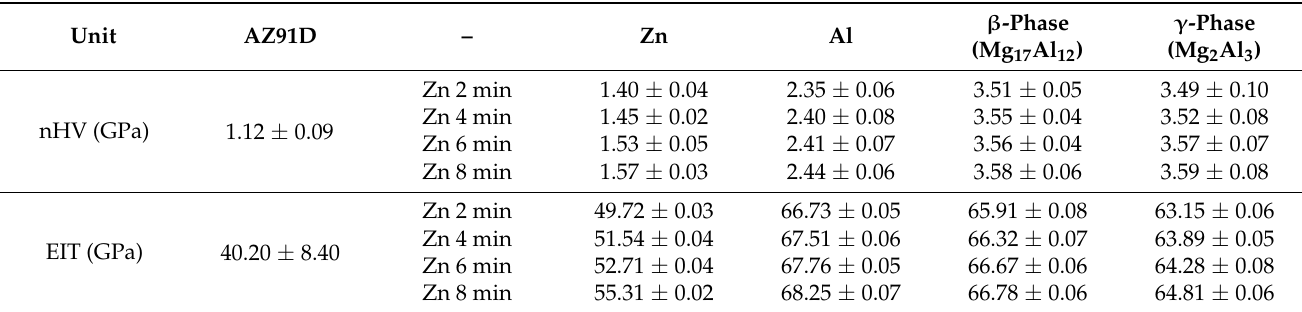
Table 3. The nanomechanical properties of the AZ91D substrate, the Zn film, the Al coating, β -